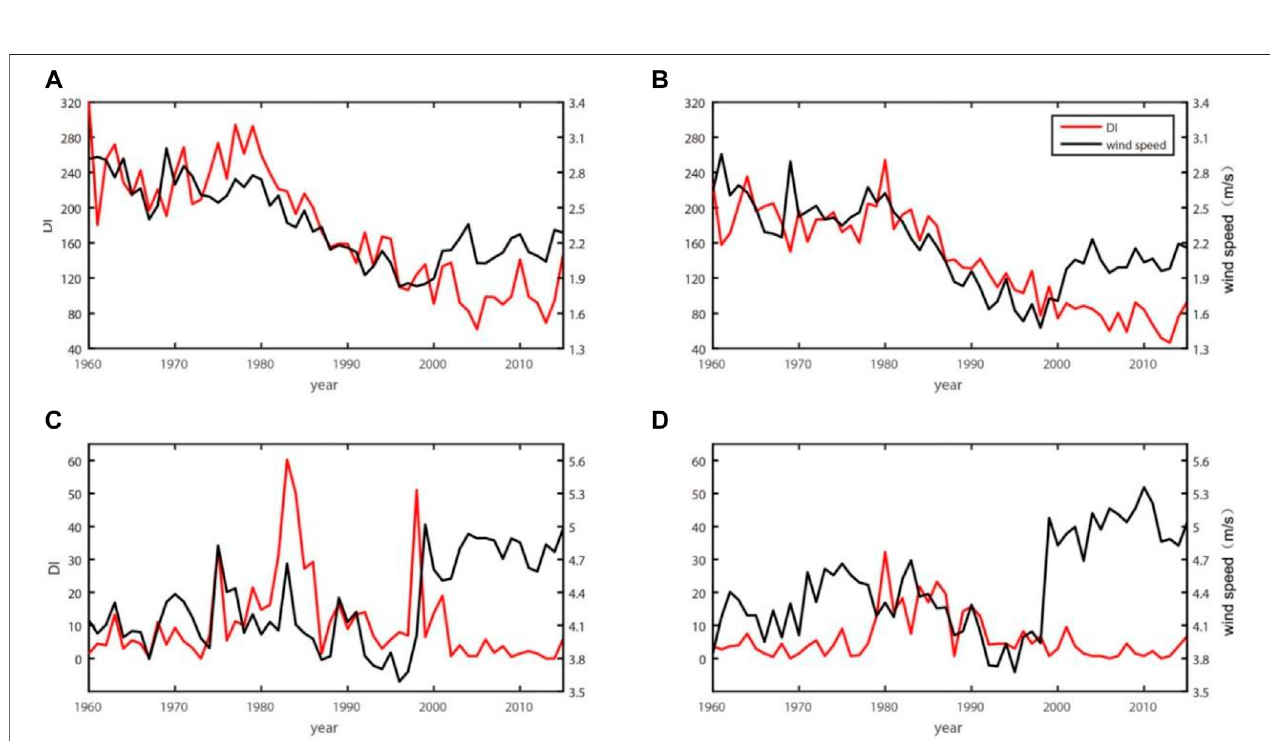
FIGURE 8 | Variations of DI and average surface wind speed: Southern Xinjiang (A,B) and Northern Xinjiang (C,D) in spring (A,C) and summer (B,D) .